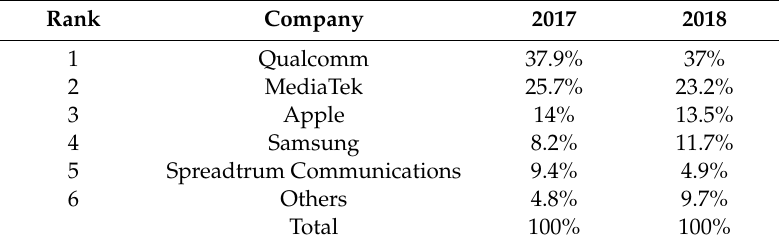
Table 3. Market share of mobile application processor in 2017 and 2018.